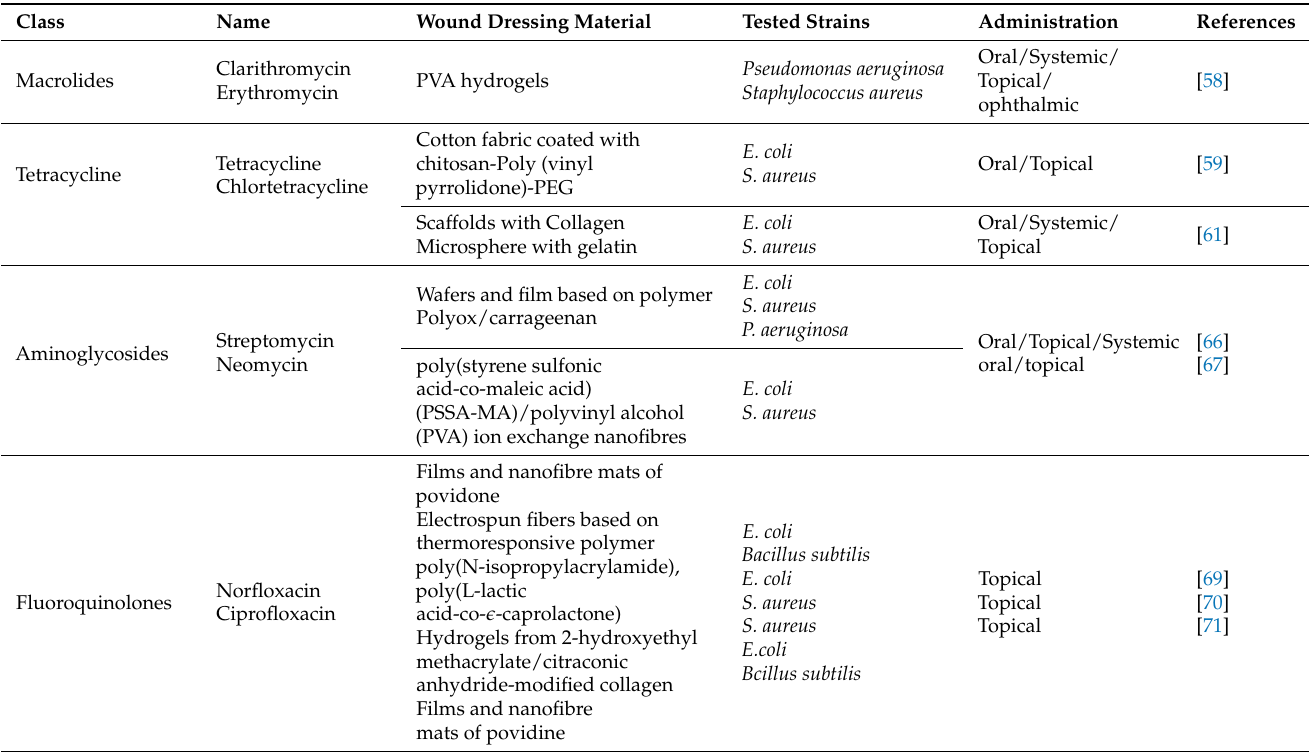
Table 1. Commonly used antimicrobial agents with target